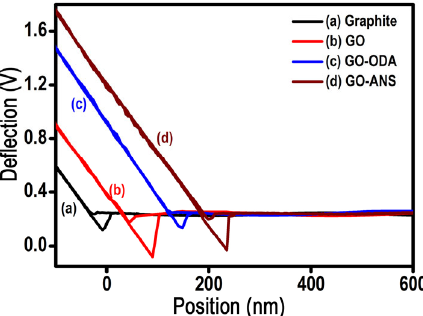
Fig. 7 Approach-retraction force-distance curves measured on graphite, GO, GO-ODA and GO-ANS